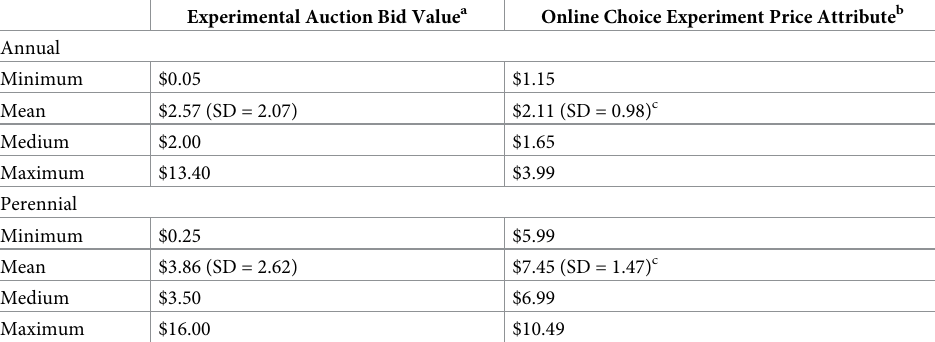
Table 5. Summary statistics of the bid and price